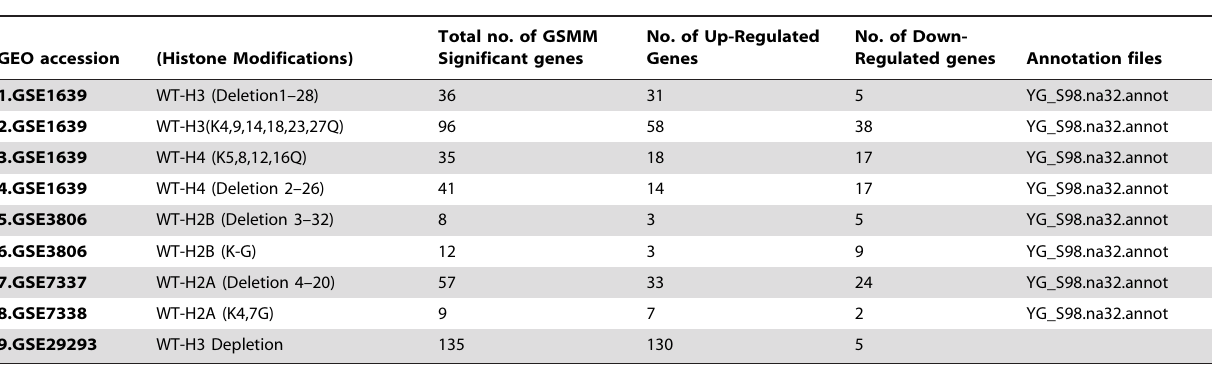
Total no. of GSMM Significant genes